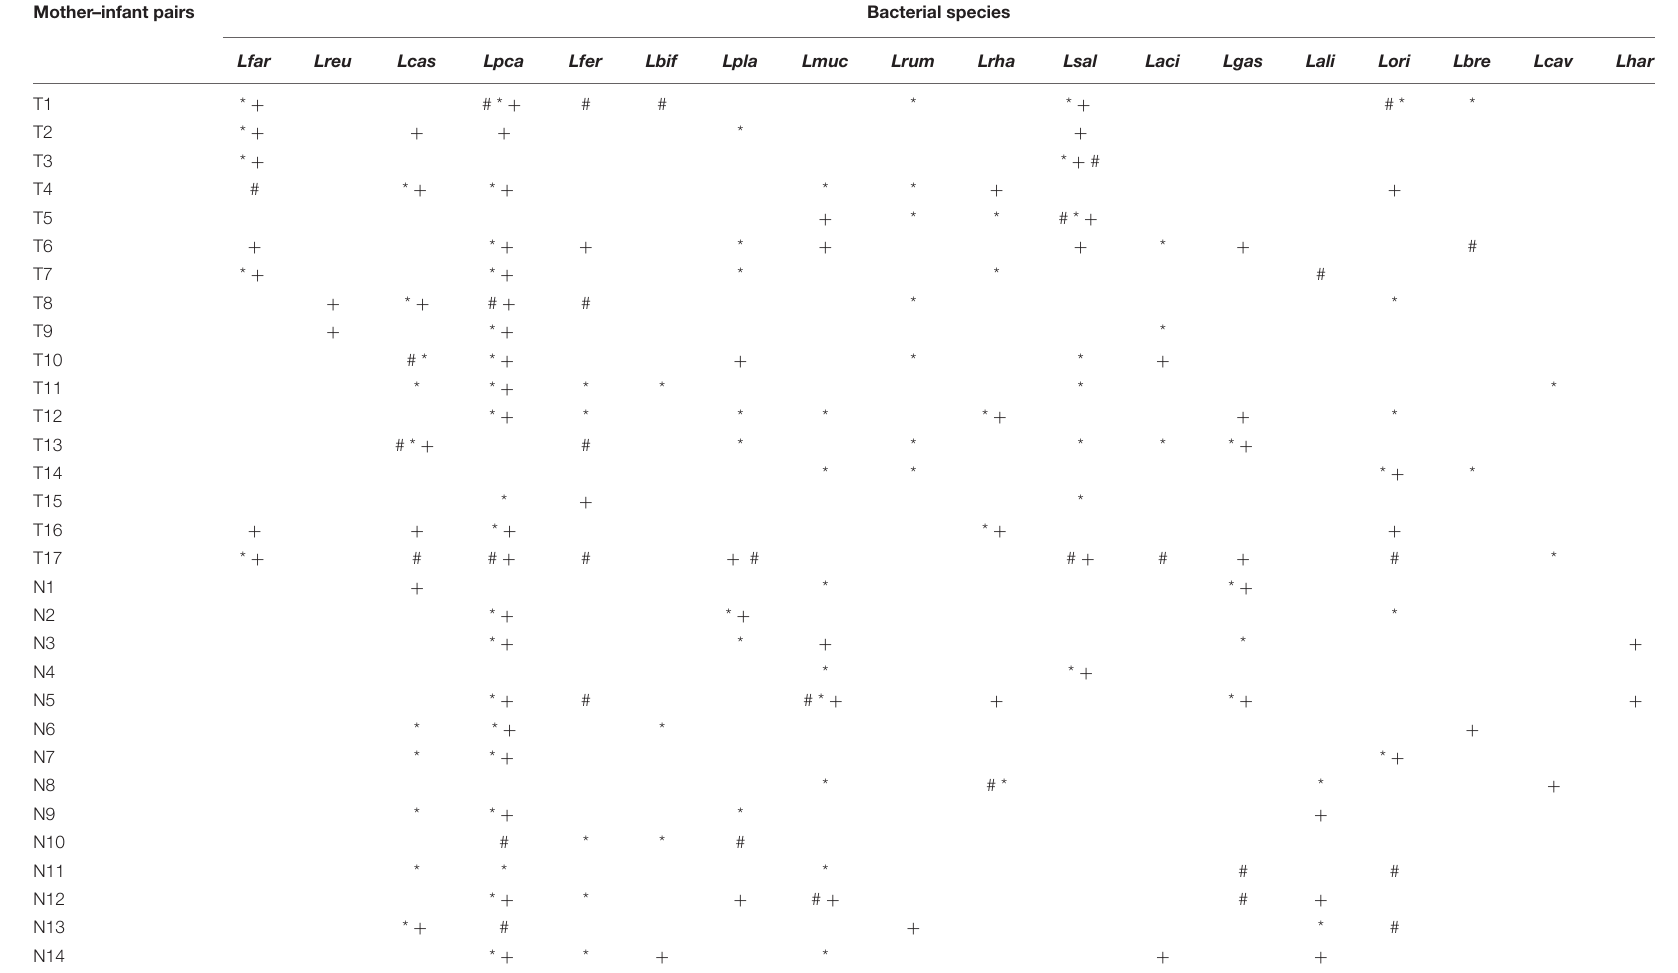
TABLE 2 | The Lactobacillus species shared by mother–infant pairs. Mother–infant